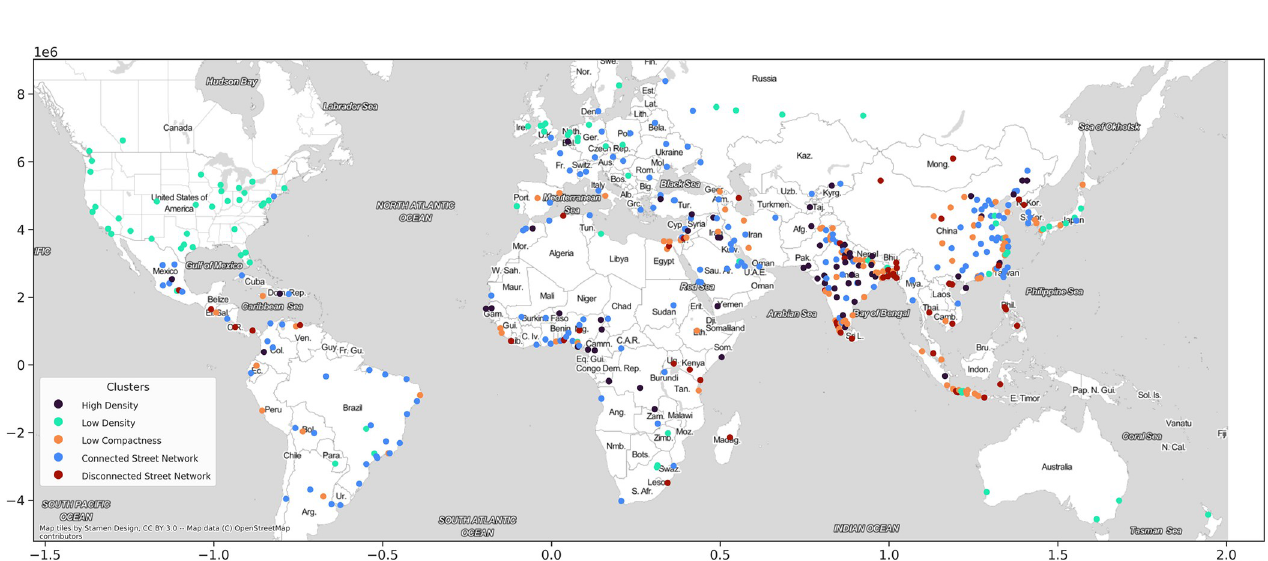
PLOS ONE | https://doi.org/10.1371/journal.pone.0278265 January 25,